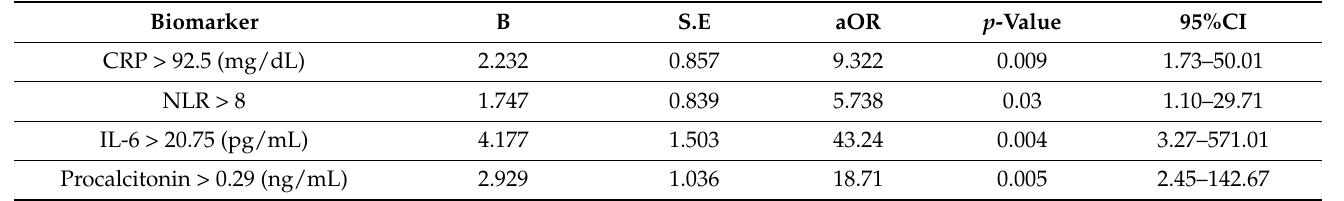
Table 3. The adjusted OR in each of the CRP, NLR, IL-6, and procalcitonin.